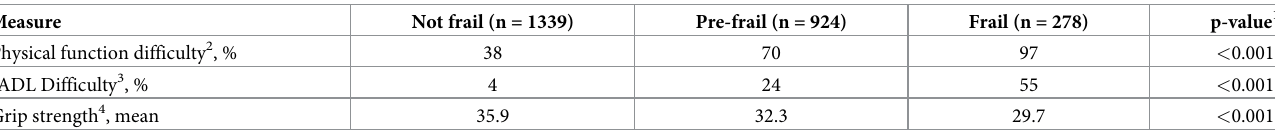
Table 3. Concurrent functional measures by frailty